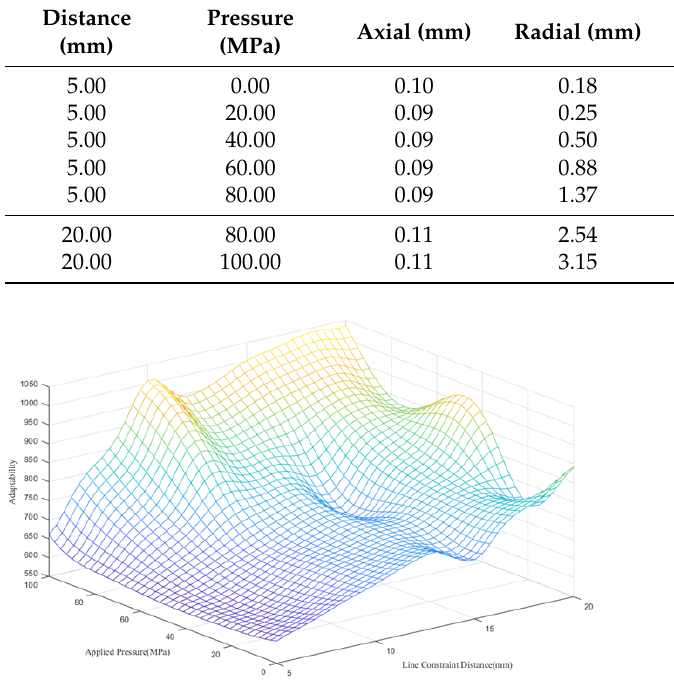
Figure 9. Diagram of the fitting plane of the Kriging